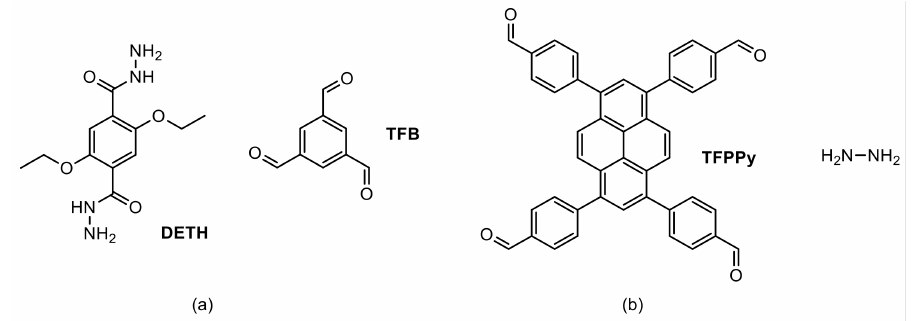
Figure 3. Structures of ( a ) COF-42 and ( b ) Py-Azine COF building